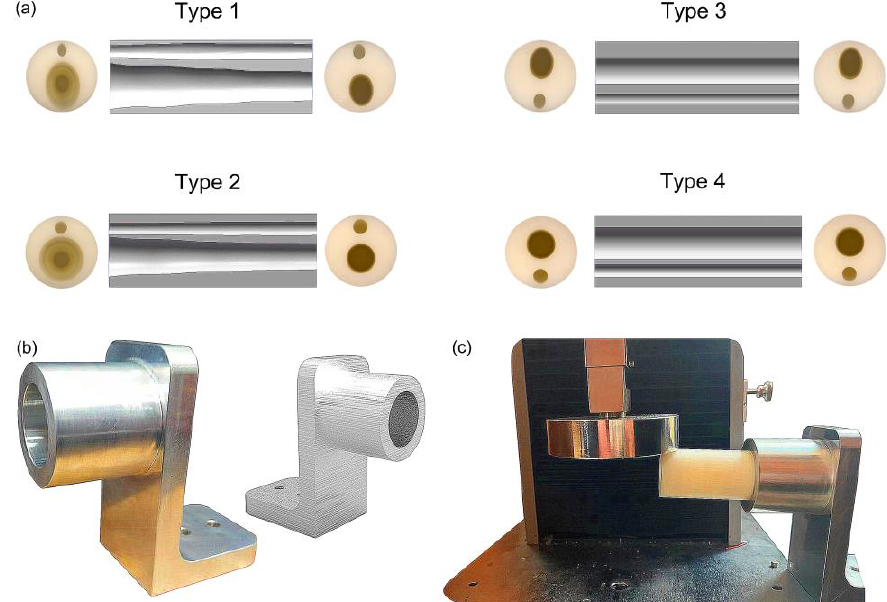
Figure 5. Fabrication and bending test of the bionic tubes: ( a ) cross-sections and inner profiles of the four tubes; ( b ) the telescopic fixture; ( c ) experimental setups.